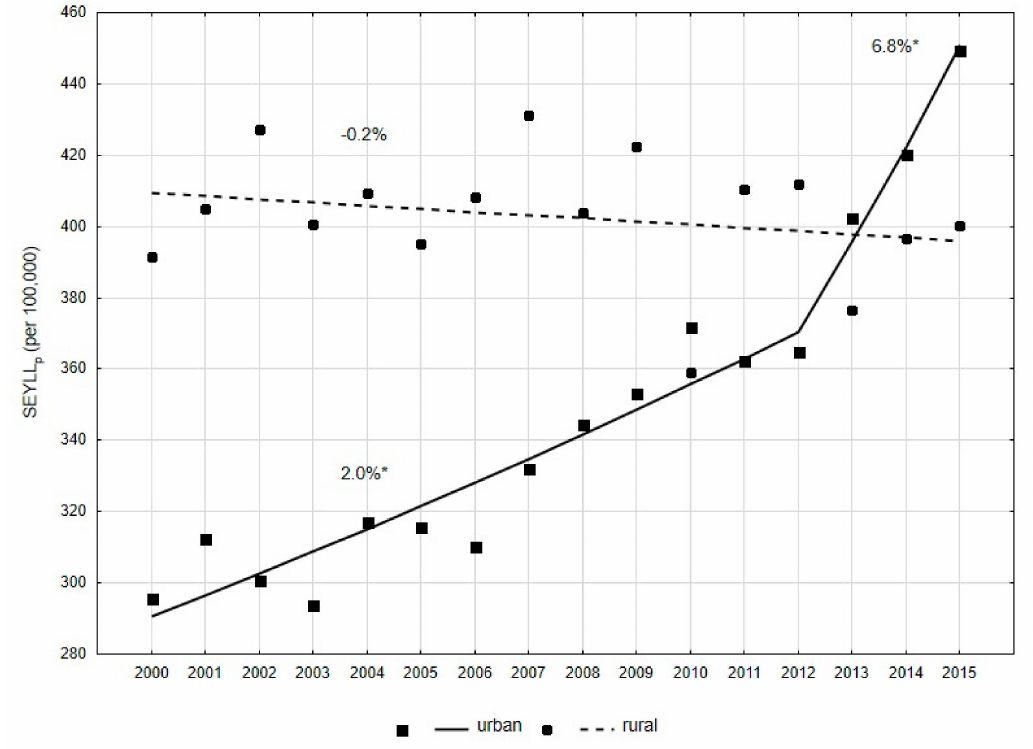
Figure 3. Time trends of the SEYLL p index due to prostate cancer by place of residence in 2000–2015 in